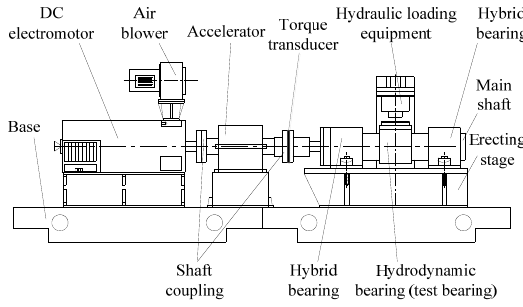
Figure 1. Schematic diagram of oil ‐ film bearing test rig.